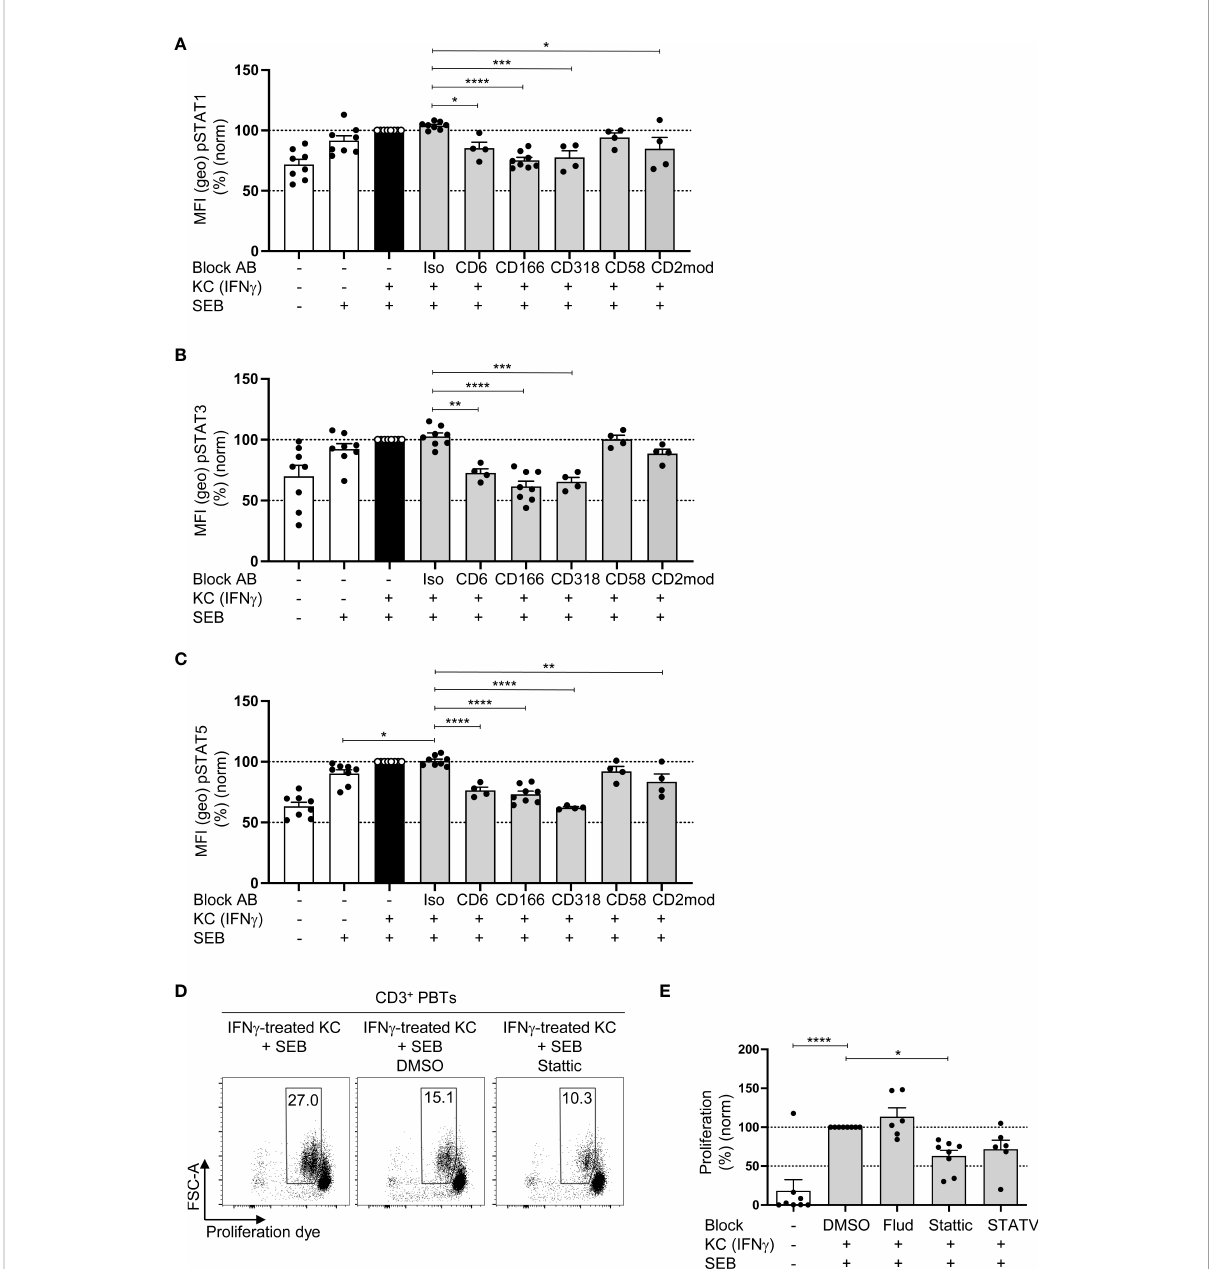
FIGURE 5 CD6-mediated phosphorylation of STAT1, STAT3 and STAT5 is involved in KC-dependent T cell proliferation. CD3 + PBTs were cultured for the indicated time points with untreated KCs (white bars) or IFN g -pretreated KCs (black and grey bars), loaded with SEB and analyzed by fl ow cytometry. (A – C) Effect of blocking antibodies against CD6, CD166, CD318, CD58, or CD2 downmodulation (CD2mod) and isotype control antibodies (iso) on the phosphorylation of (A) STAT1, (B) STAT3 and (C) STAT5 in PBTs after 24 h coculture (n ≥ 4 individual T cell donors). (D – E : (D) Representative dot plots and (E) statistical evaluation of the effect of fl udarabine (Flud), Stattic and STATV treatment on T cell proliferation after 72 h coculture (n ≥ 6 individual T cell donors). Data was normalized to PBTs cultured with IFN g -pretreated KCs loaded with SEB (black bar). Data is represented as mean ± SEM. ****=p<0.0001; ***=p<0.001; **=p<0.01;